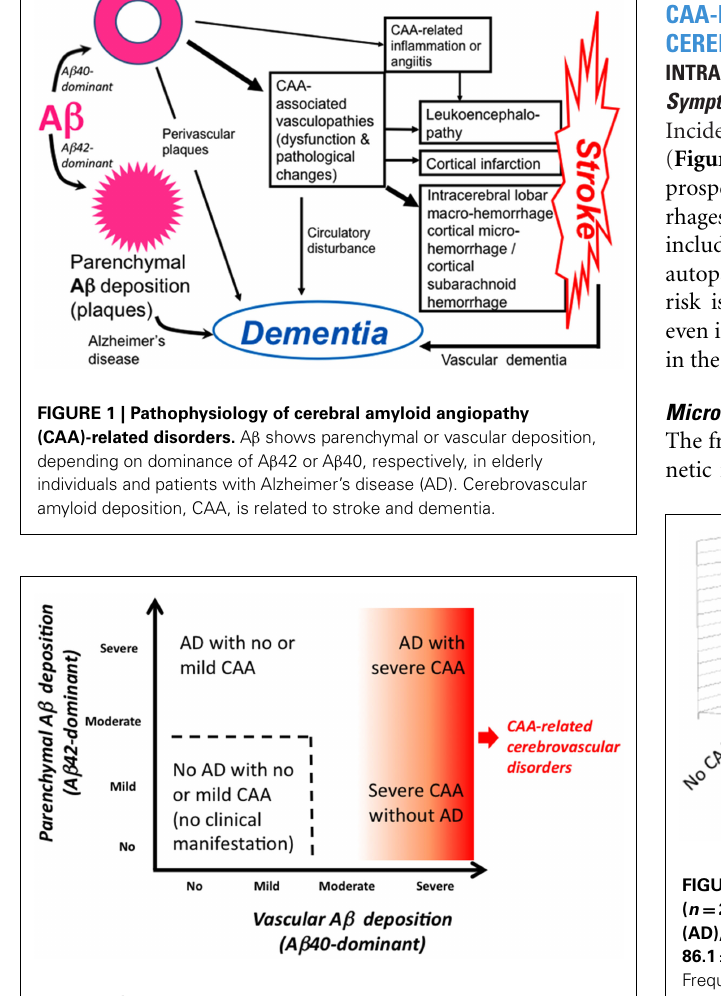
FIGURE 2 |The spectrum of cerebralA β amyloidosis.